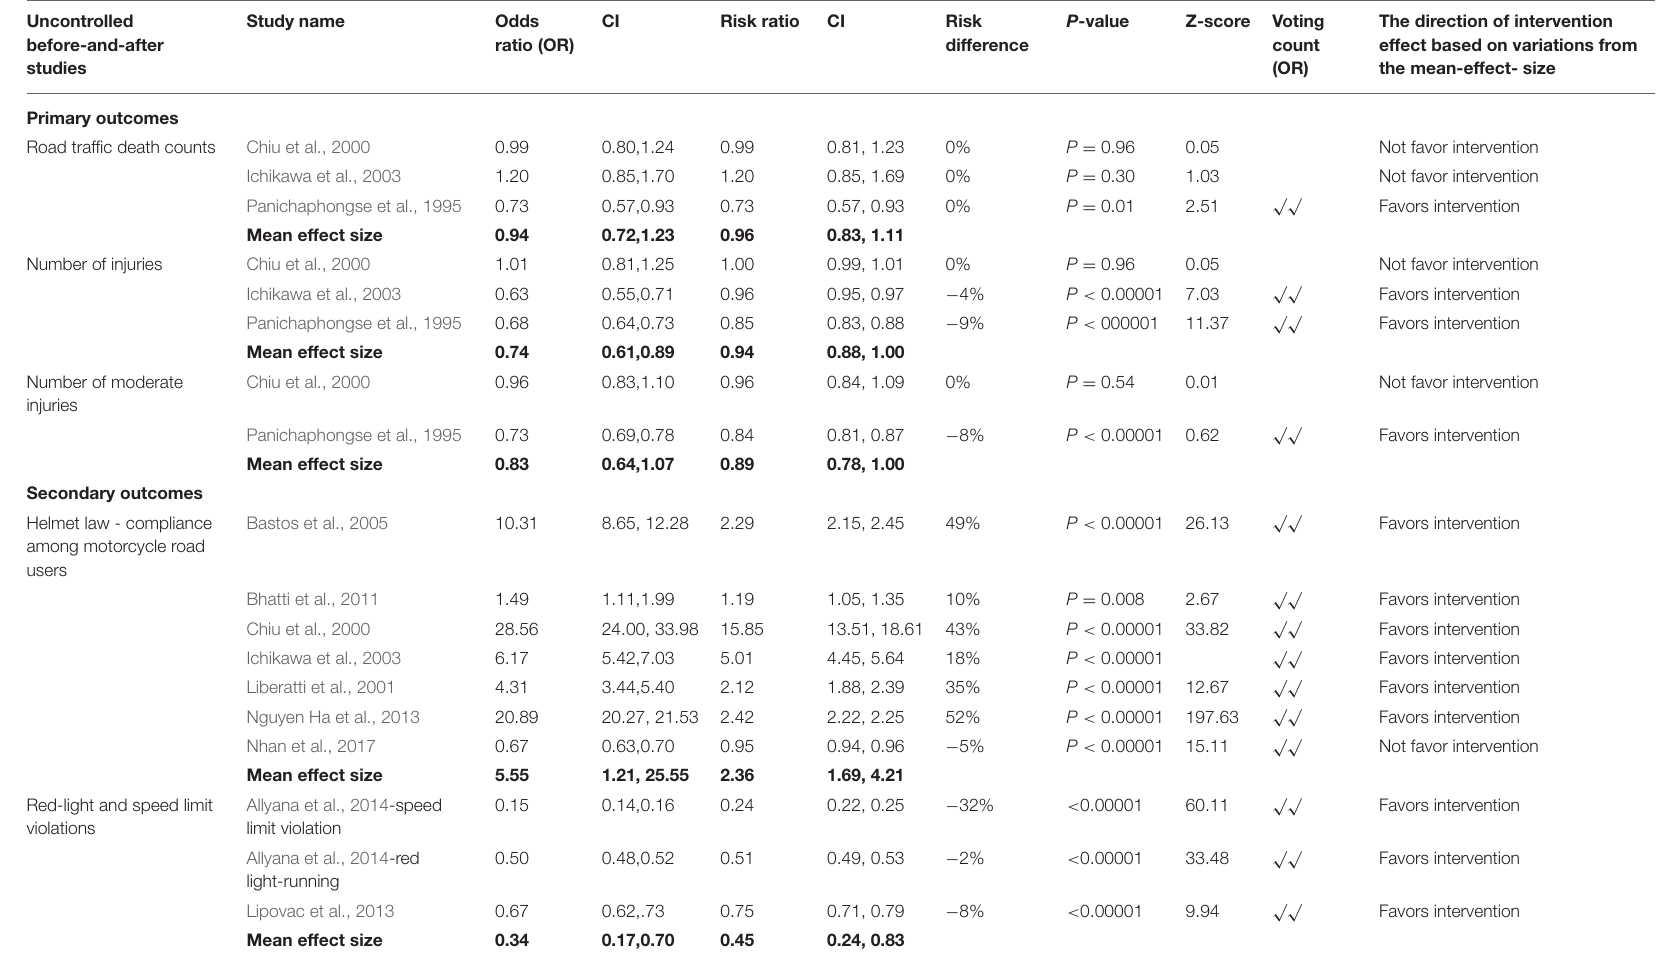
TABLE 3 | Vote counting and the common rubric of enforcement of traffic laws and regulations.